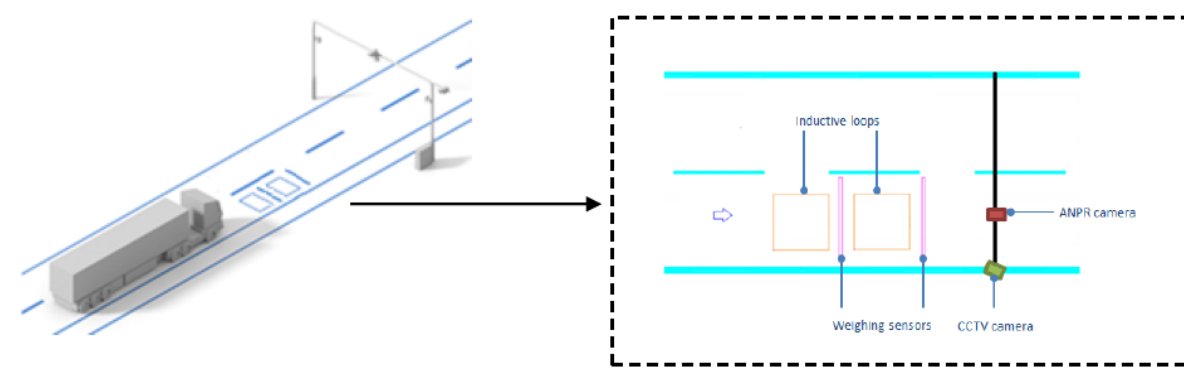
Figure 2: Diagram of an HS-WIM station (source: based on